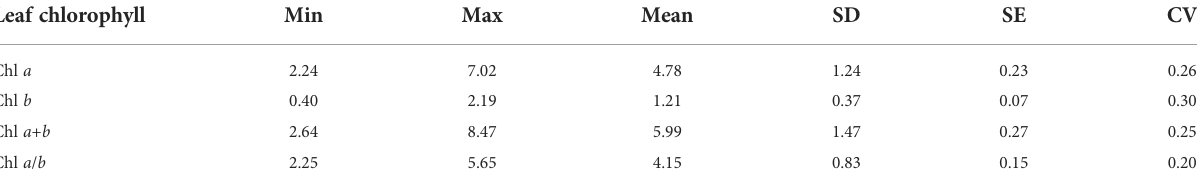
TABLE 2 Statistics of leaf content (mg g − 1 ) and ratio for Haloxylon ammodendron . Leaf